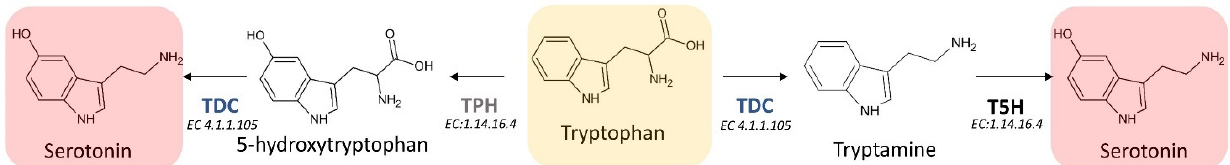
Figure 4. First two reactions of the melatonin biosynthetic pathway leading to the formation of the essential intermediate serotonin. TDC: L-tryptophan decarboxylase; TPH: tryptophan hydroxylase; T5H: tryptamine 5-hydroxylase; EC: enzyme commission number).